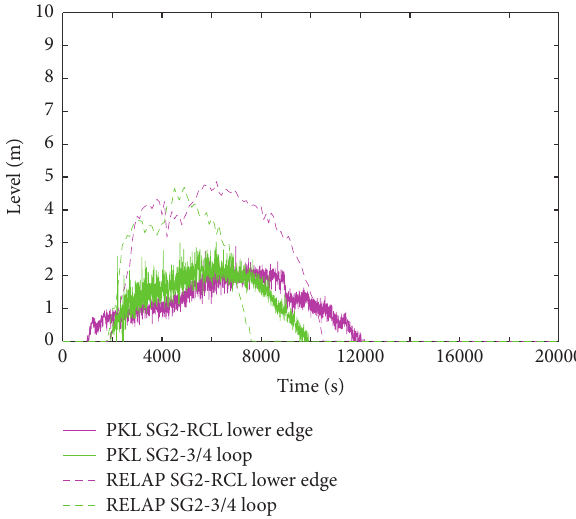
Figure 4: Inlet U-tubes SG2 levels. PKL versus RELAP5. Level influence. Phase